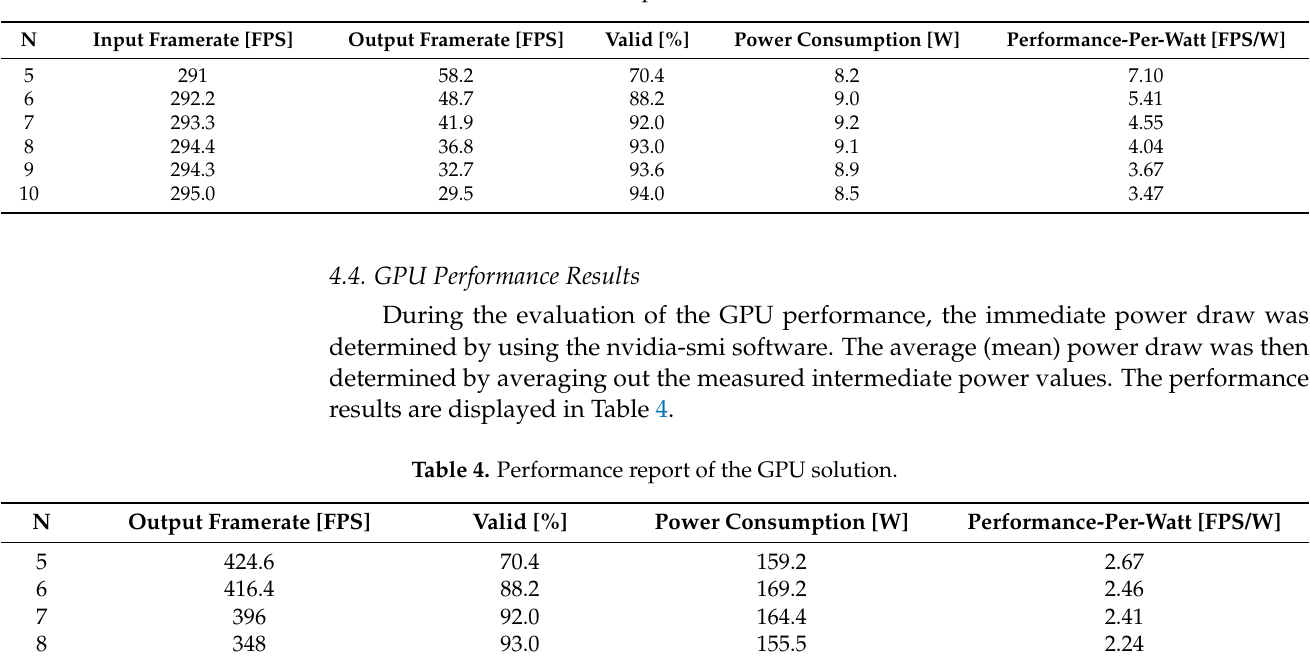
Figure 11. Overview of the validity of disparity results. ( a ) At N = 5, heavy artifacts are present. ( b ) At N = 10, only minor artifacts are present, mostly limited to the occluded areas of the disparity map. ( c ) At N = 400, there are almost zero or no artifacts. The last example is considered the ground truth for determining the validity. Table 3. Performance report of the FPGA solution.